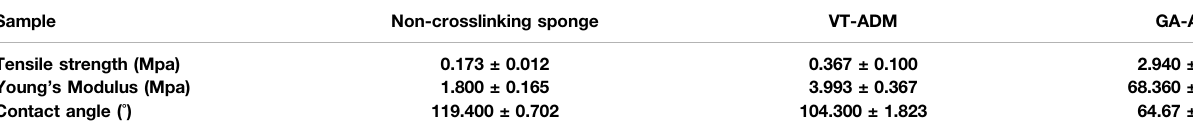
TABLE 2 | Tensile strength, Young ’ s Modulus, and contact angle of ADM sponges.